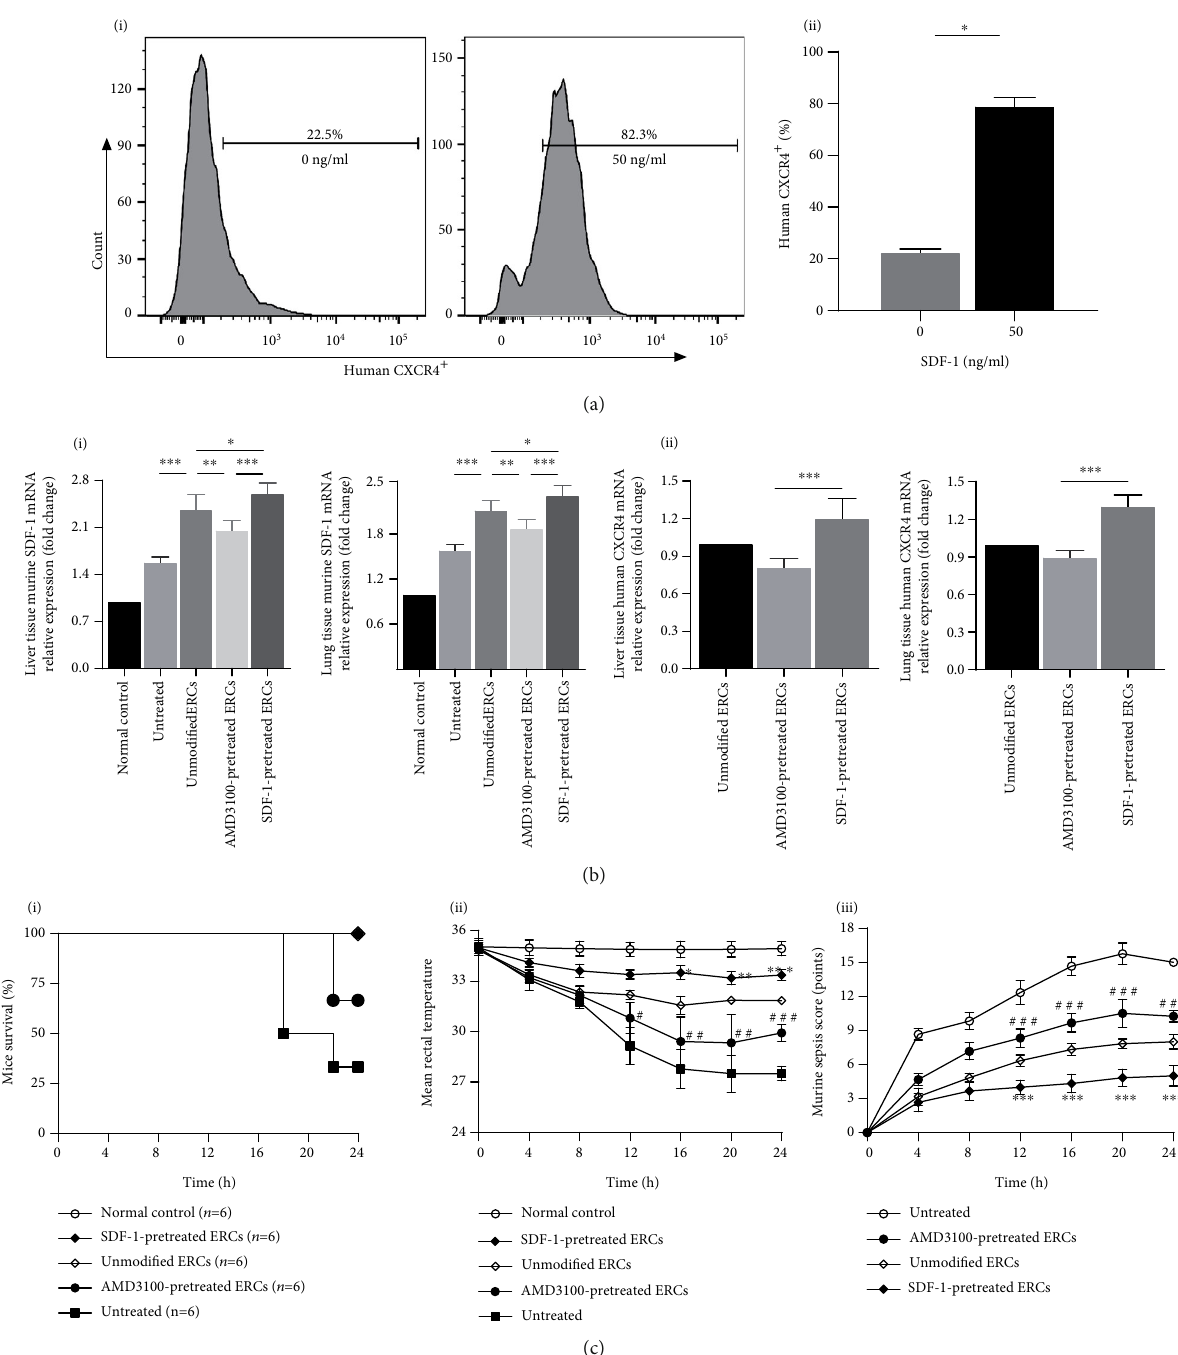
Figure 1: Pretreatment with SDF-1 on ERCs promoted SDF-1 and CXCR4 expression and further improved sepsis symptoms. (a) The expression of human CXCR4 on the surface of ERCs pretreated with SDF-1 at 0ng/ml and 50 ng/ml for 72 hours. Statistical analysis was performed by Mann-Whitney U , n = 6 , and ∗ p < 0 : 05 . (b) The mRNA expression levels of murine SDF-1 and human CXCR4 in liver (i) and lung (ii) tissues. Statistical analysis was performed by one-way analysis of variance (ANOVA), and the posttest was the least signi fi cant di ff erence (LSD) test, n = 6 . ∗ p < 0 : 05 , ∗∗ p < 0 : 01 , and ∗∗∗ p < 0 : 001 . (c) The survival rate (i), mean rectal temperature (ii), and mean murine sepsis score (iii). There was no death found in normal control group, unmodi fi ed ERC group, and SDF-1-pretreated